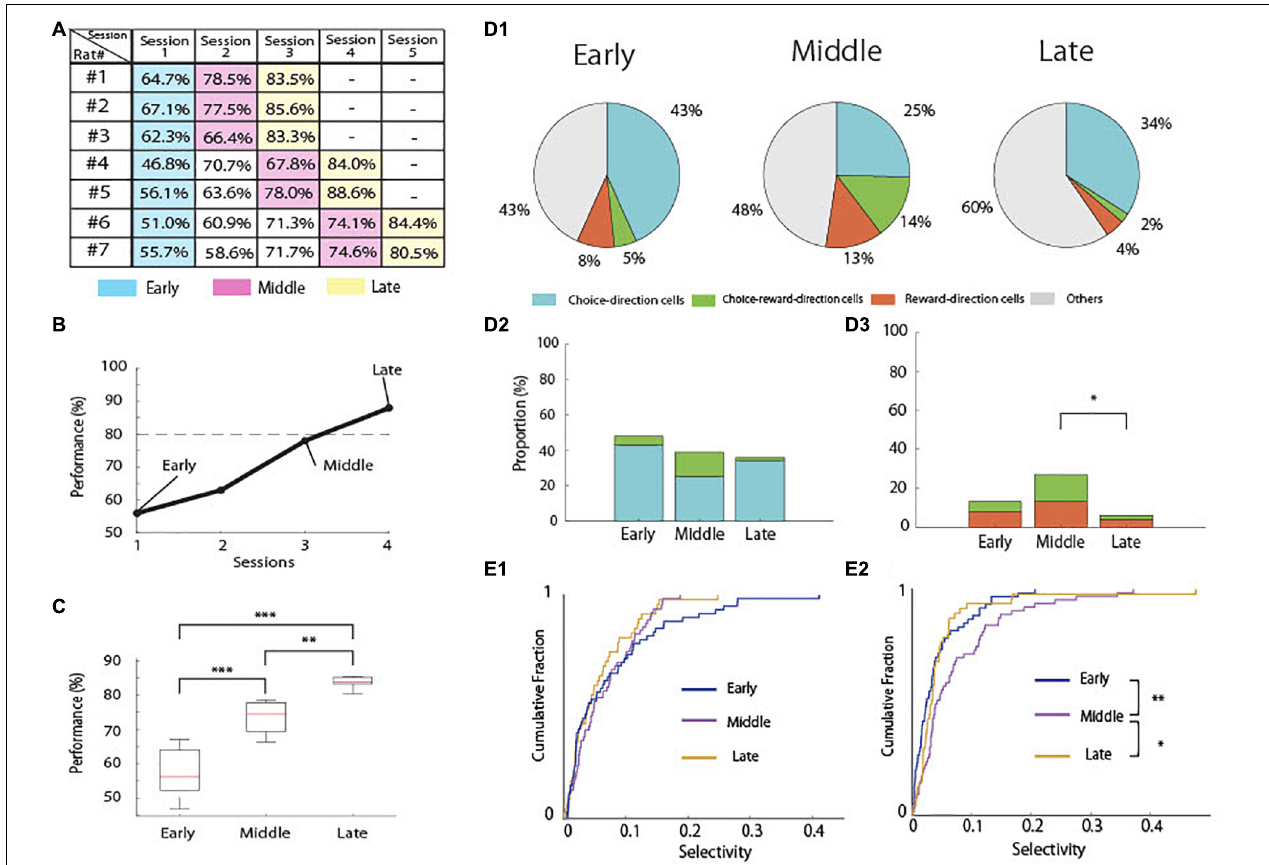
FIGURE 4 | Behavioral learning stages and proportion of task-related cells. (A) An example of performance in the associative memory task (rat #1). The dashed line indicates 80% correct. (B) Performance accuracy of the task in each rat in each session. (C) Mean correct performance in the task in each learning stage in all rats ( n = 7). (D1) Proportion of task-related cells in each learning stage. (D2) Comparison of the proportions of choice-direction cells including choice-reward-direction cells among the learning stages (Chi-square test and Fisher’s exact test with Holm correction). (D3) Comparison of the proportions of reward-direction cells including choice-reward-direction cells among the learning stages (Chi-square test and Fisher’s exact test with Holm correction). (E1) Cumulative density plots comparing the selectivity of choice-direction cells including choice-reward-direction cells among the learning stages in choice epoch. (E2) Cumulative density plots comparing the selectivity of reward-direction cells including choice-reward-direction cells among the learning stages in reward epoch (Kruskal–Wallis test and Multiple comparison with LSD test). *** p < 0.001, ** p < 0.01, and * p <